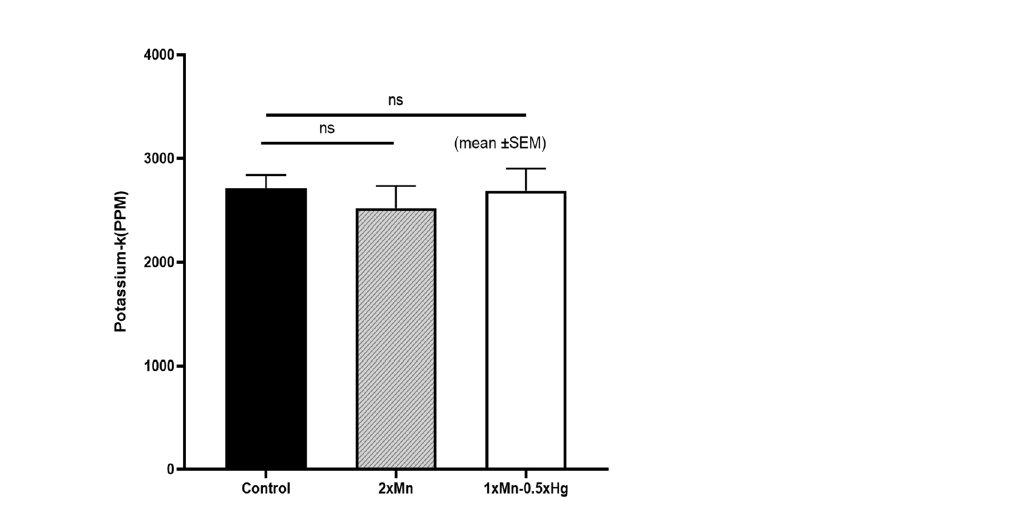
Figure 9. The mean (± SEM) potassium concentration in three groups of mice control, manganese exposed, and mercury exposed (including both male and female), showed non-significant (ns) difference, with P =